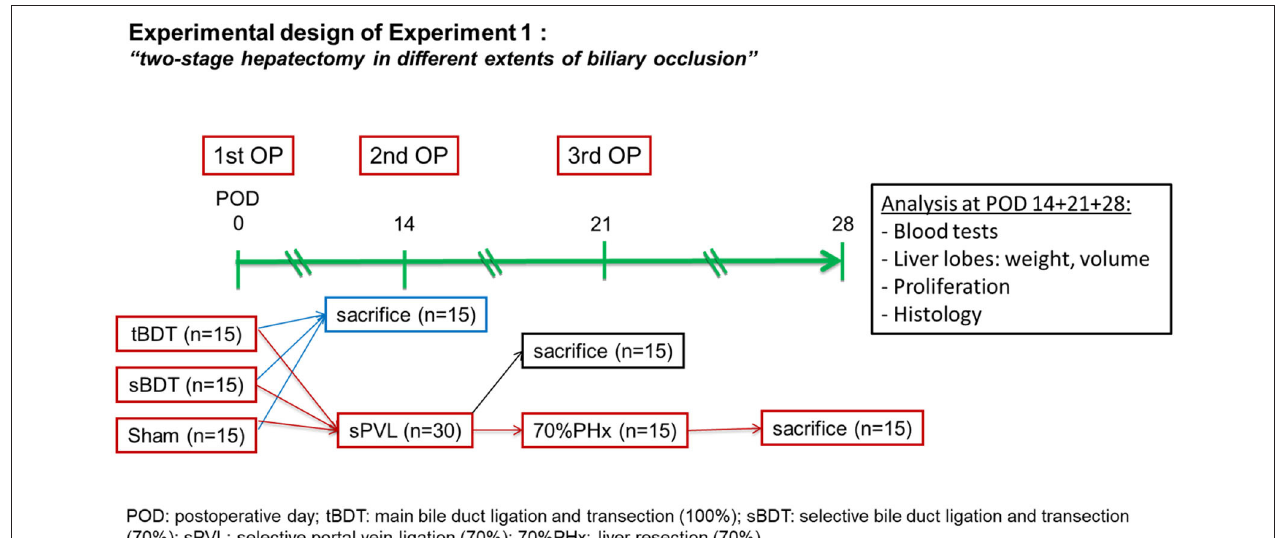
FIGURE 1 | Design of Experiment 1 with the sequence of the “two-stage hepatectomy” in different extents of biliary occlusion (tBDT 100%, sBDT 70%, Sham 0%) in rats ( n = 45). We included a group with minor (70%) and a group with total biliary occlusion mimicking Klatskin III ◦ and IV ◦ , respectively. Sham operated animals were used as control group. The 2nd procedure was a selective portal vein ligation (70% of liver) at POD 14, followed by a 70% liver resection at POD 21 and sacrifice at POD 28. We included three time points (POD 14, 21, 28) for investigation of systemic cholestasis (using peripheral blood), proliferative activity of hepatocytes and cholangiocytes and the histopathological alterations of the liver tissue in the “future resected lobes” (median lobe and left lateral lobe, ML + LLL) and future liver remnant (right lobes and caudate lobes, RL + CL) during the “two-stage